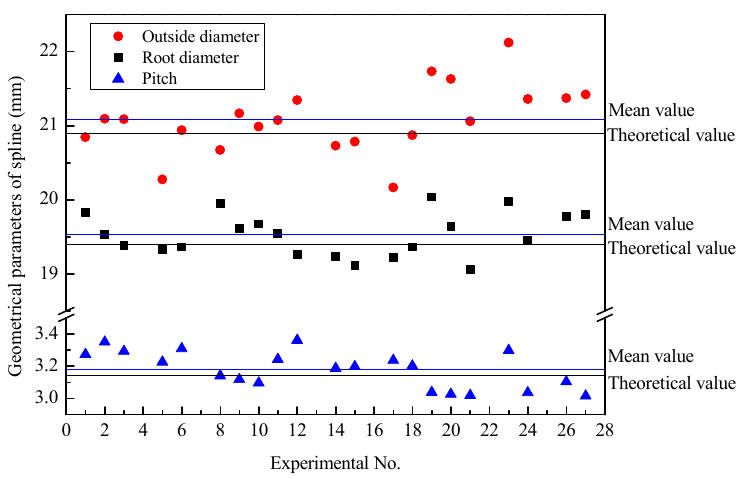
Figure 14. Basis parameters of splined section after synchronous rolling.